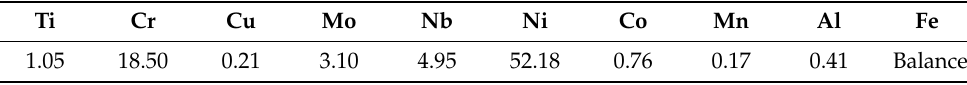
Figure 1. Measured three-dimensional geometry of employed cutting inserts edge. Table 1. Main chemical composition of employed Inconel 718, %.